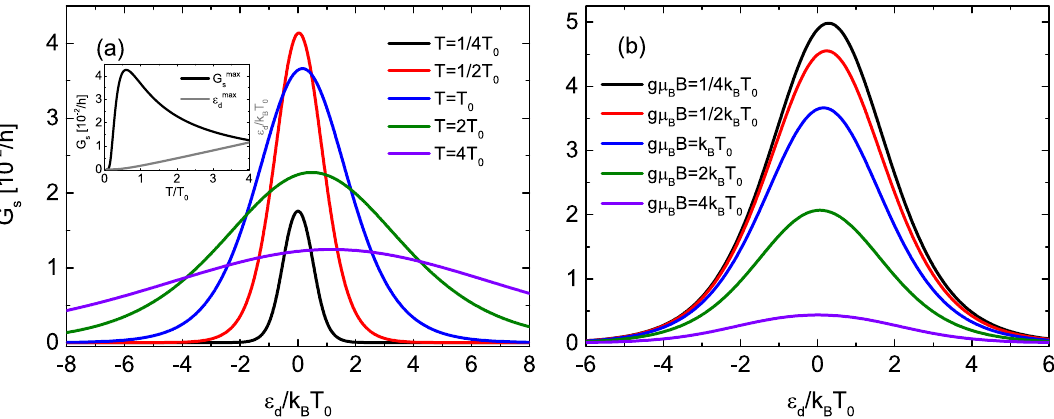
Figure 2. Spin conductance in the limit of U calculated for indicated values of ( a ) temperature and for g µ B B k B T 0 . Inset shows temperature dependence of dot’s energy level (grey) for which spin conductance for k B T = is maximal and corresponding maximal value of G s (black). The other parameters are: Ŵ e 0.1 k B T 0 =